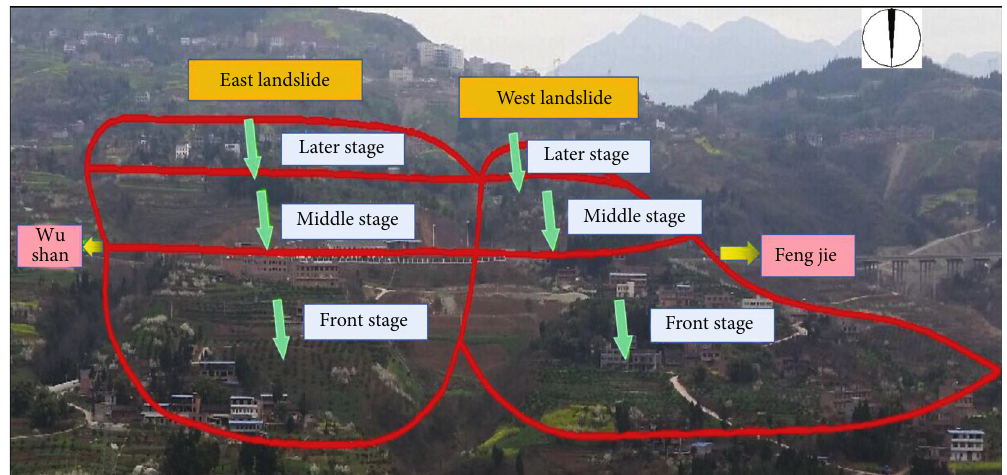
Figure 2: Block diagram of landslide